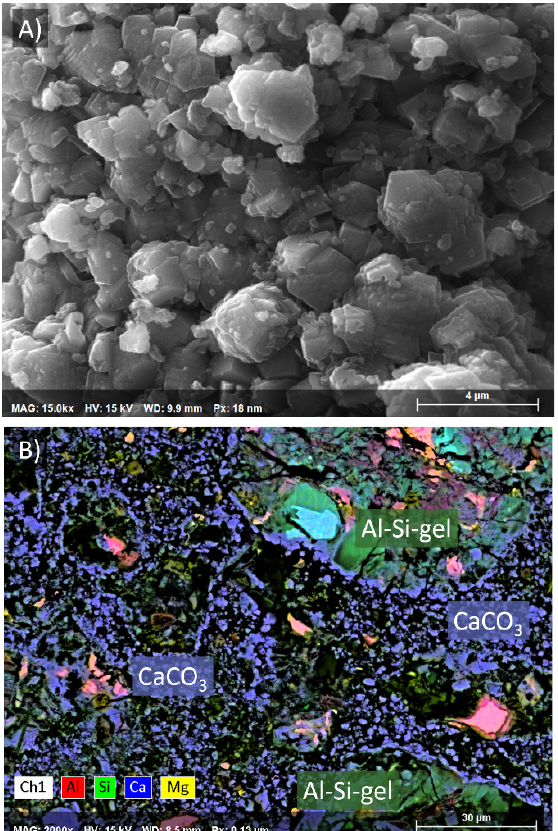
Figure 2. (A) SEM-SE picture showing the calcium carbonate morphology. (B) SEM-BSE image with elemental mapping of the carbonated cement paste. Calcium carbonate and the alumina-silica gel are highlighted. During carbonation, the principal hydrate phase, C-(A)-S-H phase, initially decalcifies to reach a Ca/Si ratio of approx. 0.67